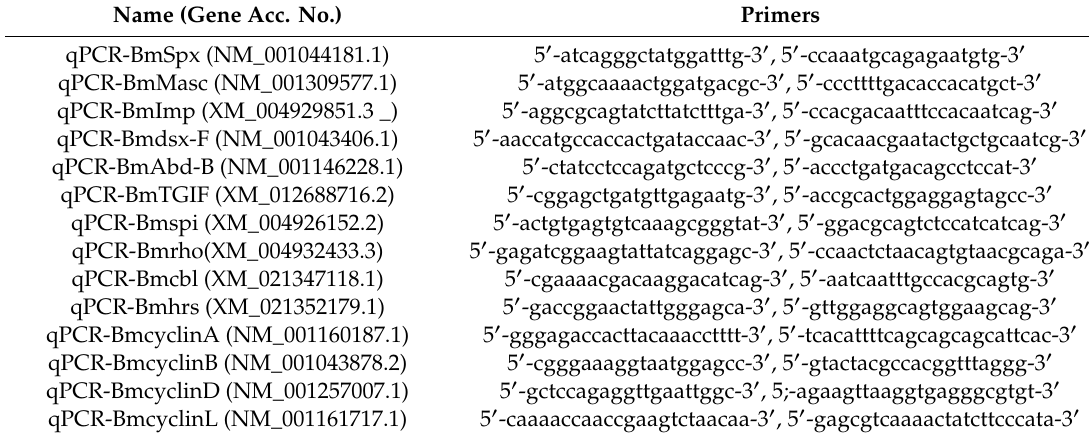
Table 3. Primer sequences for Real-time PCR.